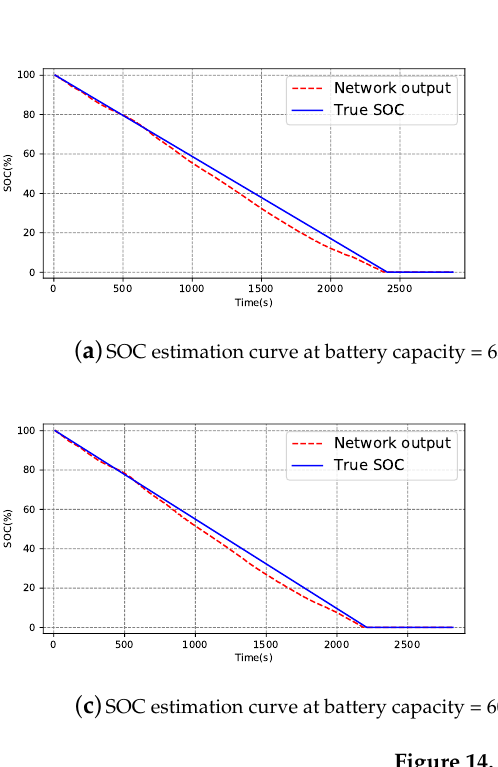
Figure 14. Estimation result at untrained data.